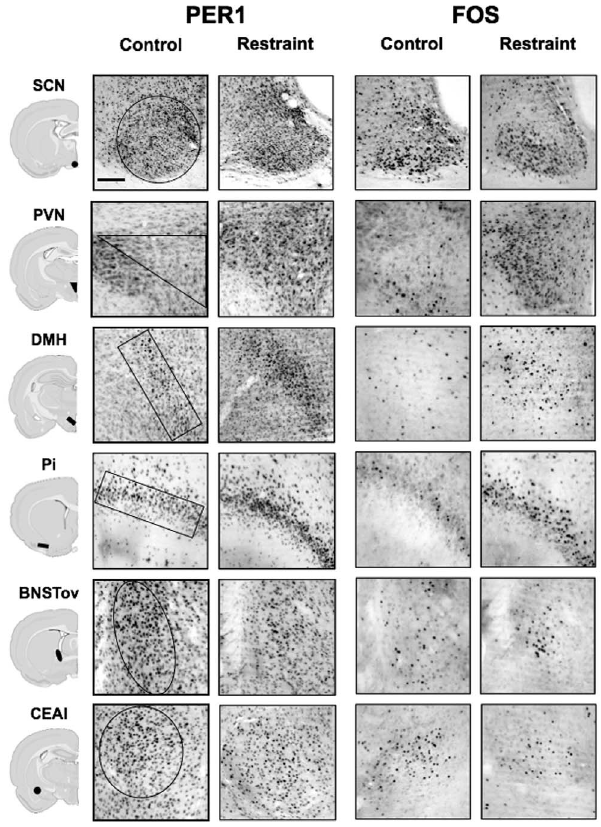
Figure 2. Photomicrographs showing examples of the effect of stress on PER1 and FOS expression in different hypothalamic and forebrain regions. Experimental rats were stressed with a 30 min restraint session at ZT2, and brains collected at ZT3 (scale bar: 100 m m). Schematics of the location of each brain structure under study are shown in the left